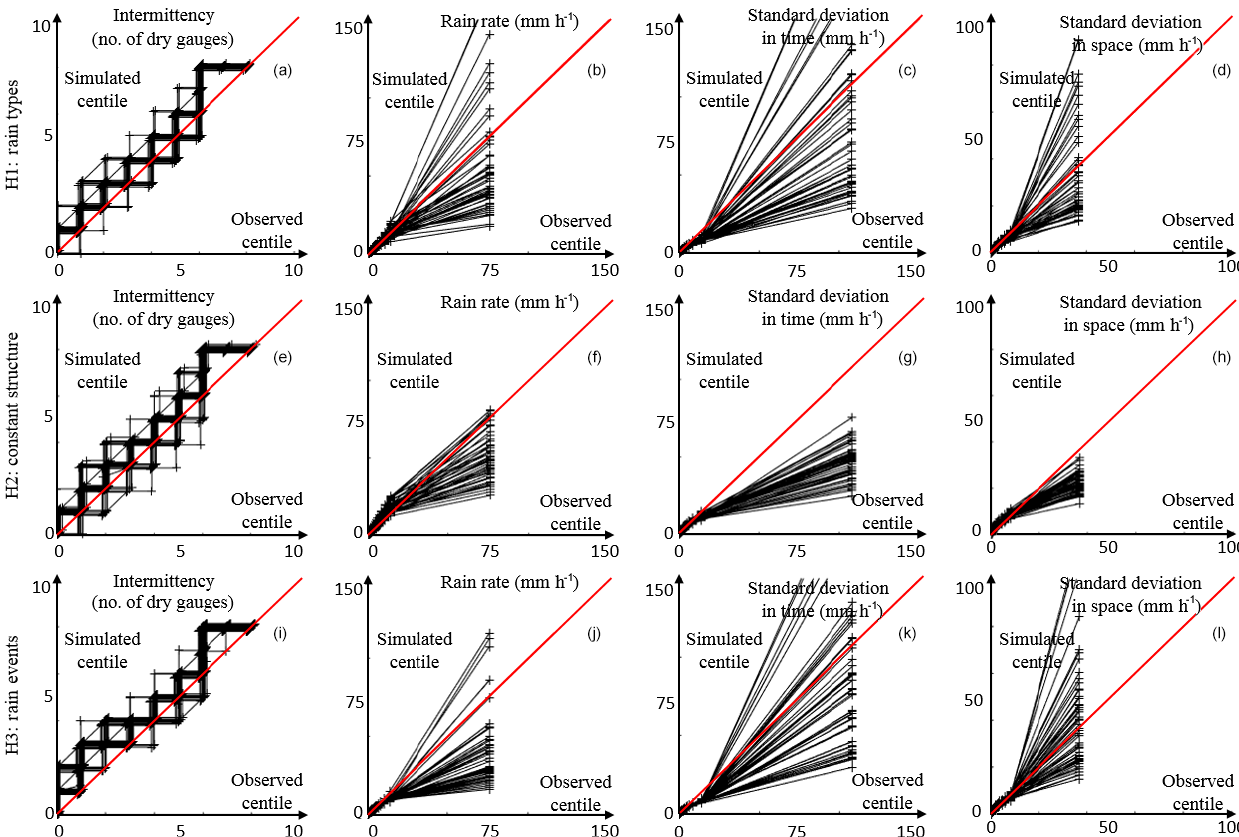
Figure 7. Reproduction of rainfall statistics for the three tested hypotheses. (a–d) Rain is stationary by rain type (H1), (e–h) rain is stationary during the entire summer period (H2), (i–l) rain is stationary by rain event (H3). (a, e, i) Quantile–quantile (q-q) plot of simulated vs. observed rain intermittency, (b, f, j) q-q plot of simulated vs. observed rain rate, (c, g, k) q-q plot of simulated vs. observed temporal variability of rainfall (at lag 5min), (d, h, l) q-q plot of simulated vs. observed spatial variability of rainfall. The quantiles used in the q-q plots are centiles. Each centile is denoted by a black